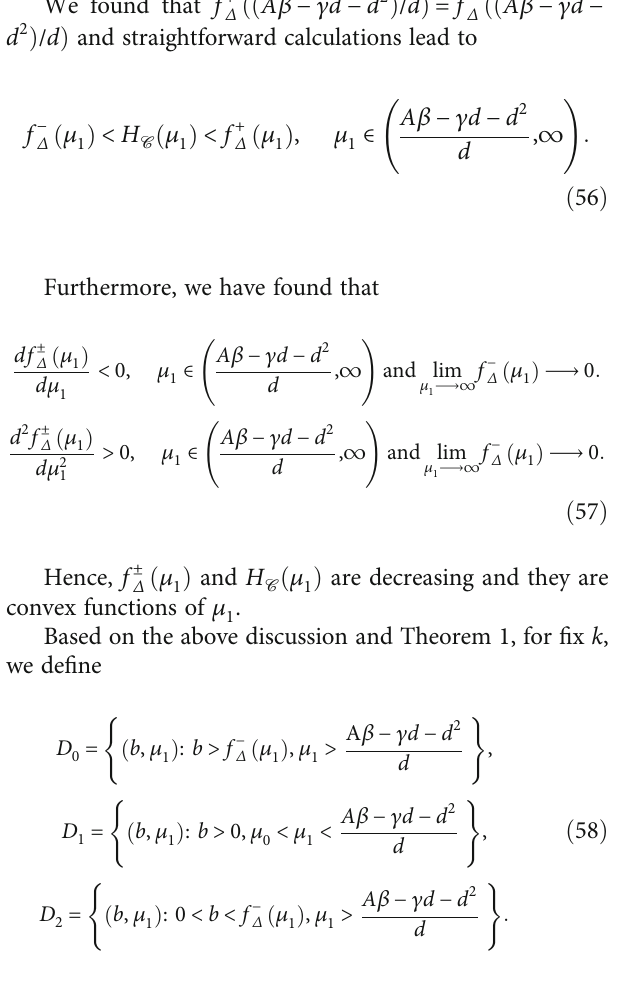
Figure 1: For fi xed k , the bifurcation curves in the ð μ when A β > d μ 0 + γ d + d 2 . In D 1 region R 0 > 1 , where there exists a unique endemic equilibrium. There are two endemic equilibria in D 2 . Two equilibria coalesce and a saddle-node bifurcation occurs on P − Δ . The forward bifurcation occurs on P − 0 and backward bifurcation occurs on P + 0 . There is no endemic equilibrium in the fi rst